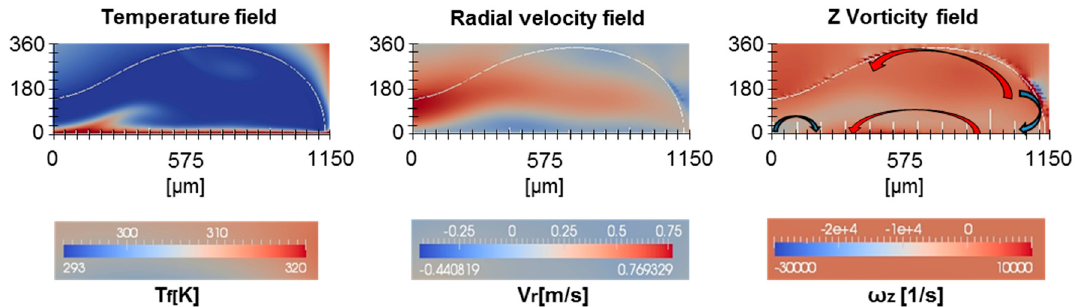
Figure 11. Numerically obtained temperature, radial velocity and z-vorticity fields within the fluid domain in the rim region. For We = 24 and Tw (in) = 353.15 K at 4 ms after impact. The z-axis is perpendicular to the plane of view. The white line identifies interface between the liquid and gas phases (alpha = 0.5).